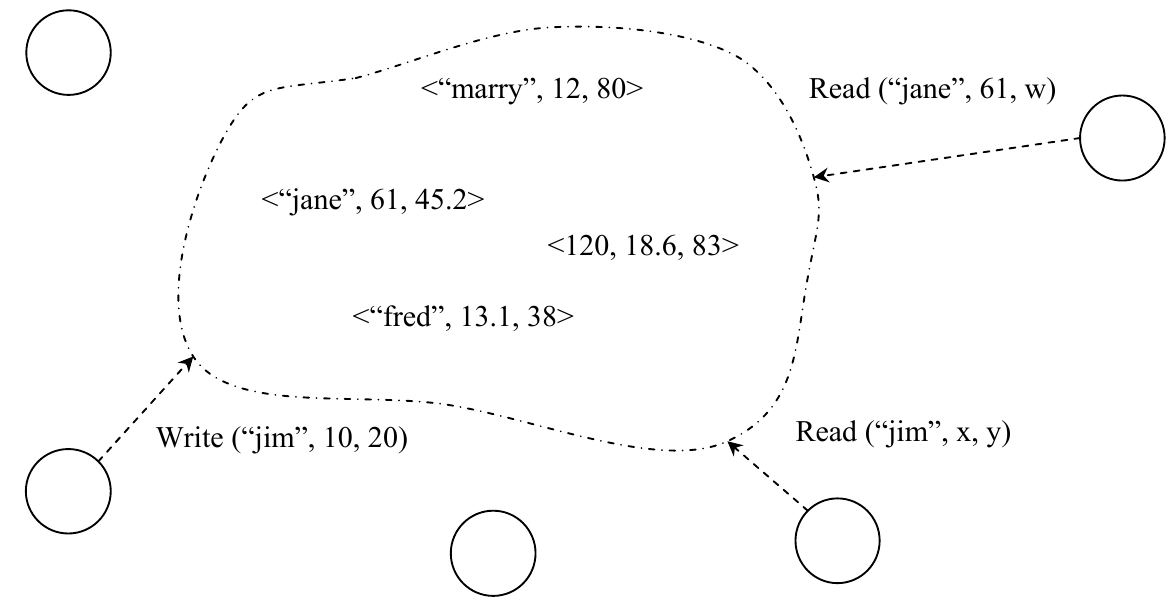
Figure 5. A symbolic tuple space. Read and write can be synchronous or